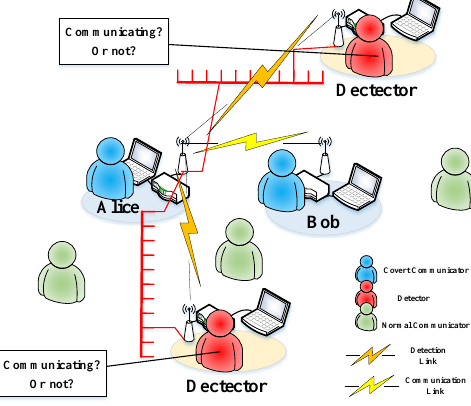
Figure 8. Wireless covert channel testbed.